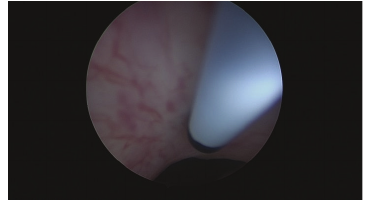
Figure 1: Bladder neck hypertrophy before the injection, causing almost complete bladder outlet obstruction (BOO).